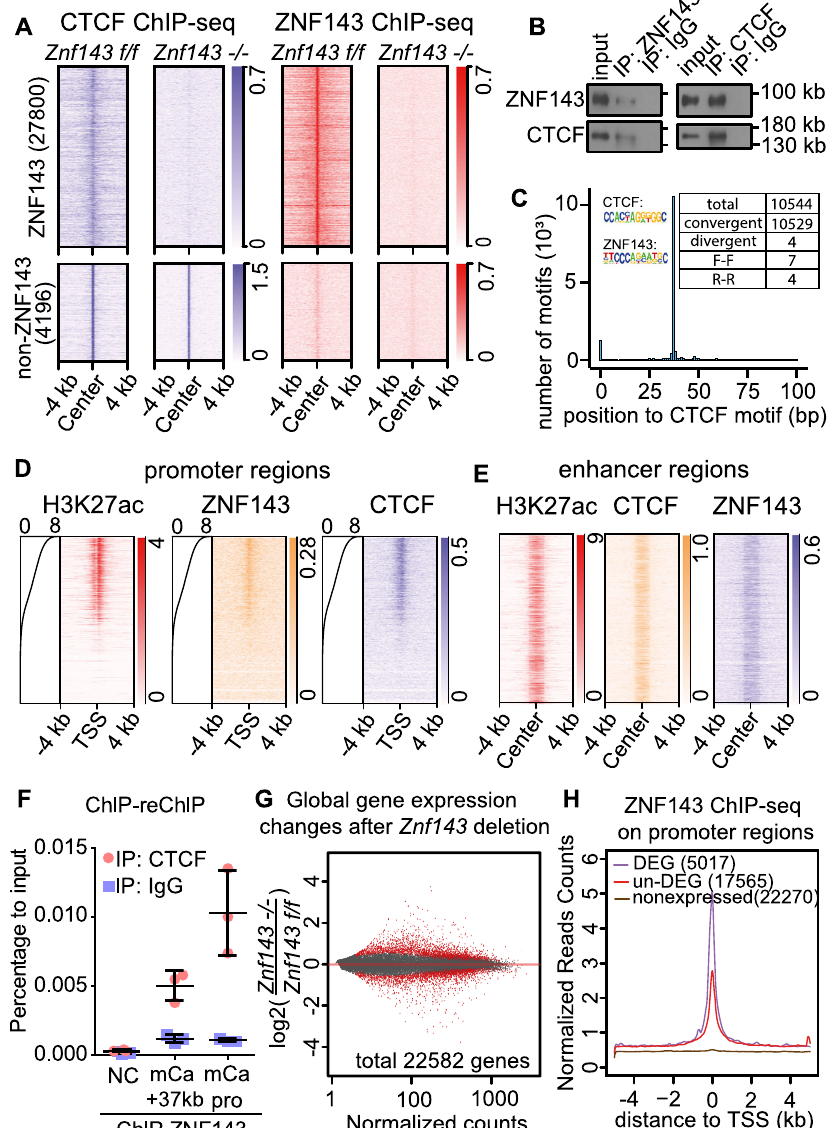
Fig. 1 ZNF143 stabilizes CTCF binding on promoter and enhancer regions to regulate gene transcription. a Heatmaps of ZNF143 and CTCF ChIP-seq in ZNF143 wild type ( Znf143 f/f ) and ZNF143 knockout ( Znf143 − / − ) murine HSPCs. b Reciprocal co-IP of ZNF143 and CTCF in murine HSPCs. Experiment is repeated independently for three times with similar results. c Histogram describing the distance between CTCF and ZNF143 motifs on the murine genome (mm10). The X -axis represents the relative distance between ZNF143 and CTCF motif, while the Y -axis represents the number of ZNF143 motifs in each bin. Each bin size is 1 bp. The table presents the number of ZNF143 motifs in the different orientation patterns to the nearest CTCF motifs within 10,544 ZNF143 motifs located 37 bp apart from the nearest CTCF motifs. d Heatmap of H3K27ac, ZNF143, and CTCF ChIP-seq in Znf143 f/f murine HSPCs within the regions ±4 kb from the transcription start site (TSS). Gene order is ranked by RNA expression from high to low in Znf143 f/f cells (heatmap from top to bottom). e Heatmap of H3K27ac, ZNF143, and CTCF ChIP-seq in Znf143 f/f murine HSPCs within ±4 kb from CTCF-bound enhancer regions. f ChIP-reChIP of ZNF143 and CTCF on a negative intergenic control region (NC), Cebpa promoter region (mCa pro), and Cebpa + 37 kb enhancer region (mCa + 37 kb) in Znf143 f/f murine HSPCs. Y -axis: the mean ± SD from triplicate experiments. g MA plot demonstrating gene expression changes between Znf143 f/f and ZNF143 − / − murine HSCs. Red dots represent differentially expressed genes ( p < 0.05). n = three biological replicates. P -value is determined by the Wald test. h The mean plot of ZNF143 ChIP-seq within ±4 kb TSS regions in Znf143 f/f murine HSPCs. Genes are divided into (1) differentially expressed genes (DEG), (2) non-differentially expressed genes (un-DEG), and 3) non-expressed genes (non-expressed) as de fi ned in ( g ). HSPCs: c-kit + , lineage- cells; HSCs: LSK + (lineage-, Sca-1 + , c-kit + ), CD150 + , CD48- cells. ChIP-seq in panels ( a ), ( c ), ( d ), ( e ), and ( h ) was performed in two biological